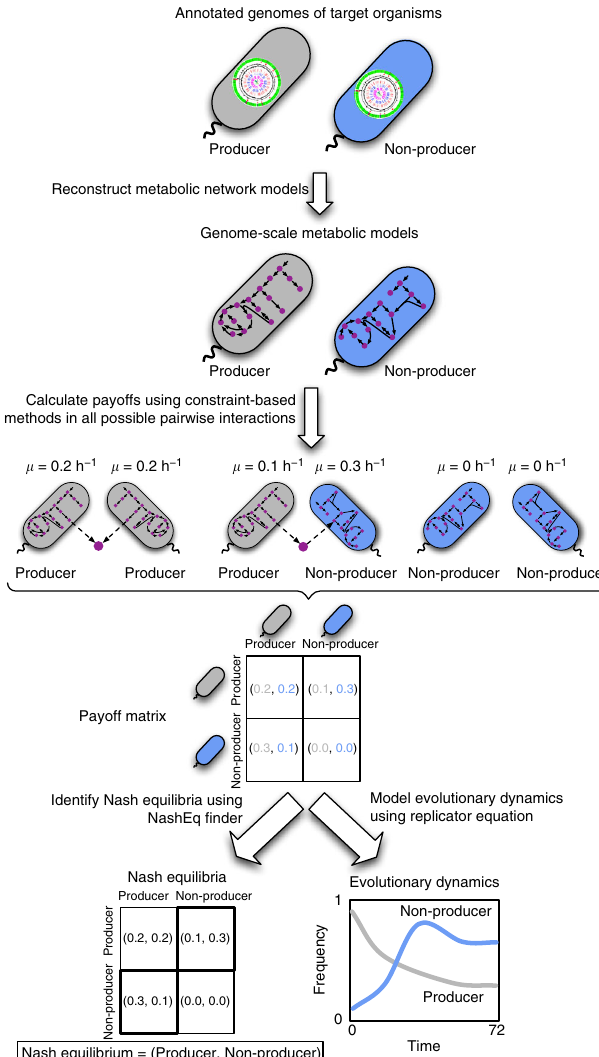
Fig. 1 General scheme for the proposed genome-driven evolutionary game theory approach. Annotated genomes of community members are used to construct genome-scale metabolic models. For each possible pair of genotypes in the community, constraint-based analysis tools for metabolic models, such as fl ux balance analysis 51 , are used to estimate the fi tness (or “ payoff ” ) of each genotype as they engage in a speci fi c metabolite- mediated interaction. These payoffs form the payoff matrix of the game. Based on this payoff matrix, we identify all pure strategy Nash equilibria of the game, using an automated pipeline (NashEq Finder, see “ Methods ” ). The payoff matrix also allows one to model evolutionary dynamics (i.e., how genotype frequencies change over time) 33 and to determine which of the identi fi ed Nash equilibria are evolutionarily stable (see “ Methods ”